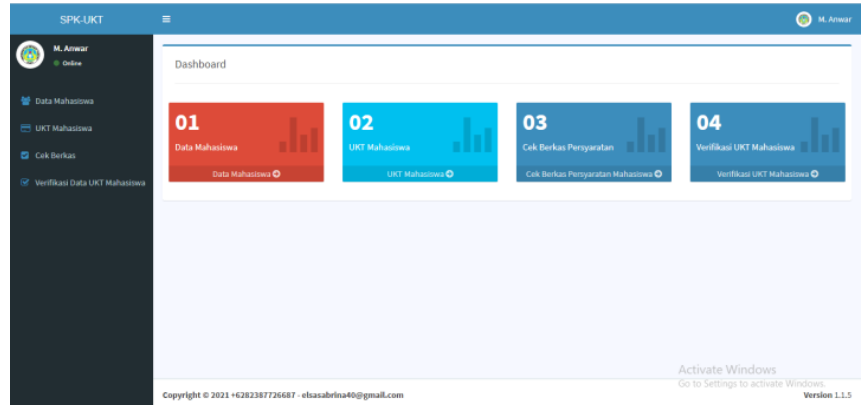
Figure 8. Main page of the Vice Dean